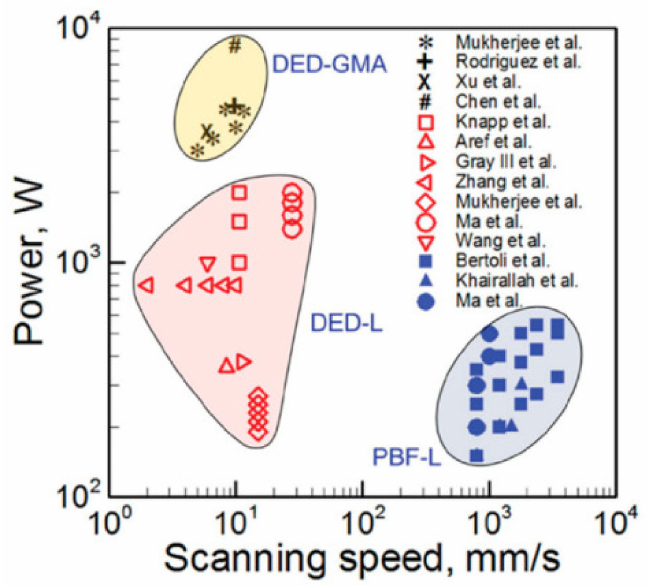
Figure 23. Power and welding speed for different additive manufacturing processes for 316L stainless steel [30] (DED-L = direct energy deposition laser, PBF-L = laser-based powder bed